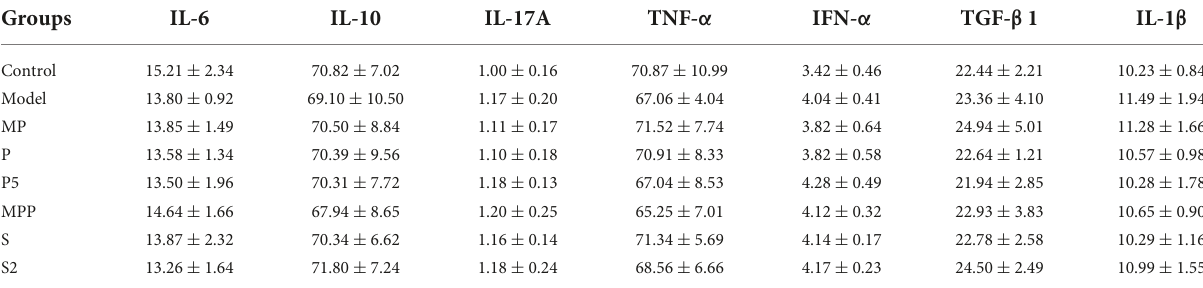
TABLE 2 Serum cytokine concentration in different groups (ng/L).